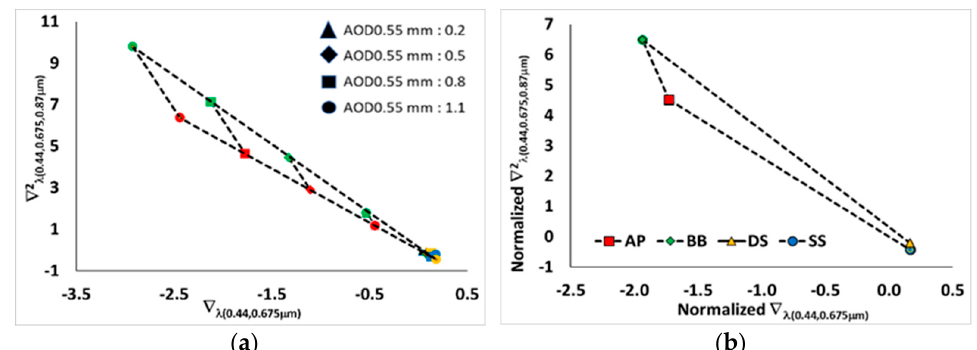
Figure 4. Relationships between the first and second-order derivatives before ( a ) and after ( b ) normalization with AOD 0.44µm for each aerosol type: anthropogenic pollutant (AP: red), biomass burning (BB: green), dust (DS: yellow), and sea salt (SS: blue) under various AOD 0.55µm inputs (triangle: 0.2, rhombus: 0.5, square: 0.8, and round: 1.1).